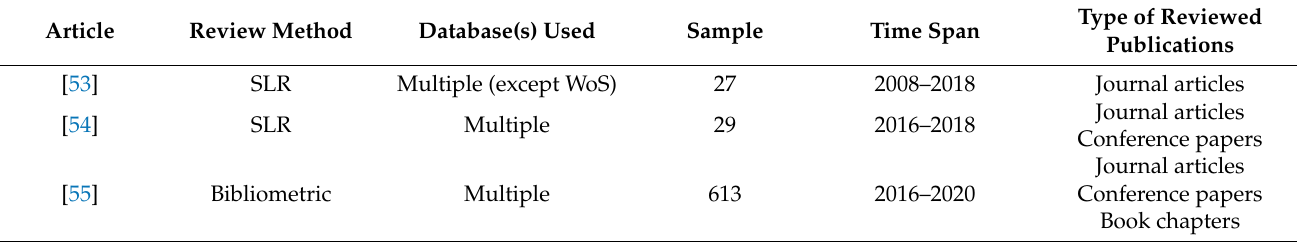
Table 1. Review studies on blockchain in the logistics and SCM